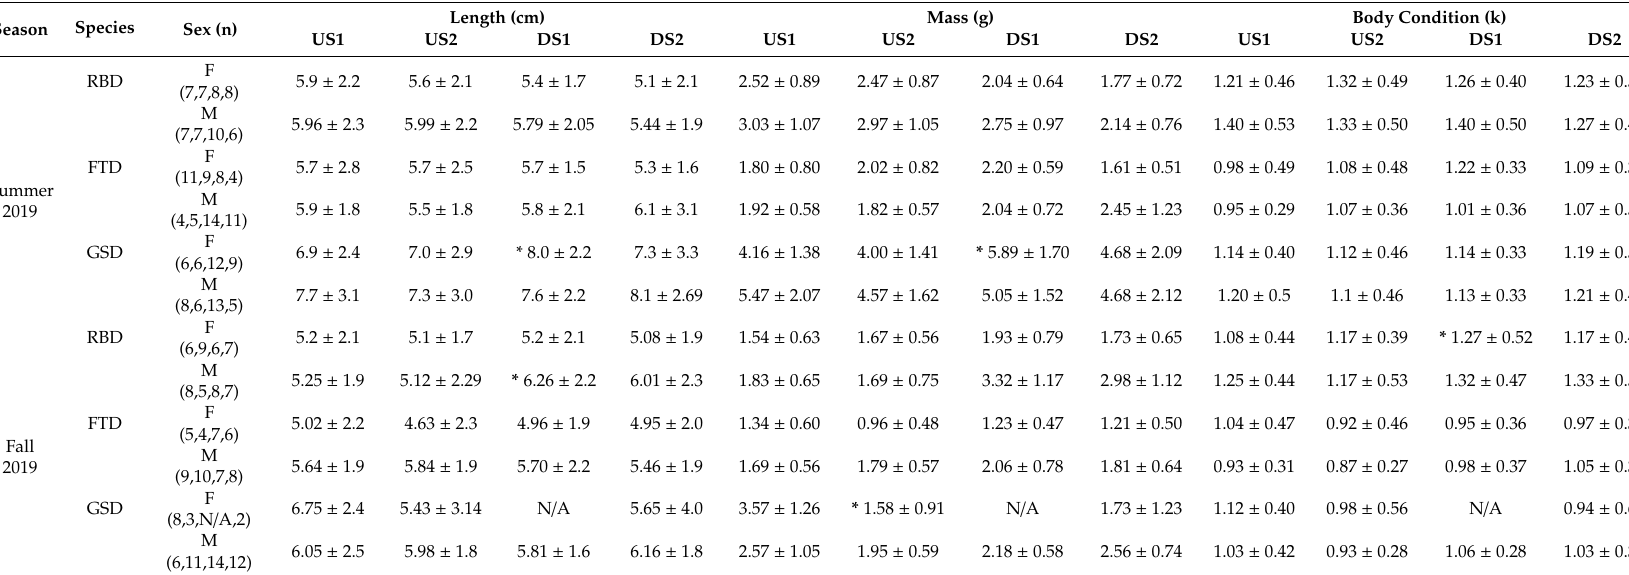
Table 3. Summary of the length (cm), mass (g), and body condition ( k = 100 × ( m / l 3 ), m —mass in grams, l —length in cm) of three darter species collected throughout the study. Data are presented as mean ± SEM. The numbers of samples ( n ) are presented in the sex column, in order from US1 to DS2. An asterisk indicates the average values that were significantly di ff erent (Dunnett’s multiple comparisons test, p < 0.05) than those found at the reference site, US1. RBD, rainbow darter; FTD, fantail darter; GSD, greenside darter; F, female; M, male; US1, upstream 1; US2, upstream 2; DS1, downstream 1; DS2, downstream